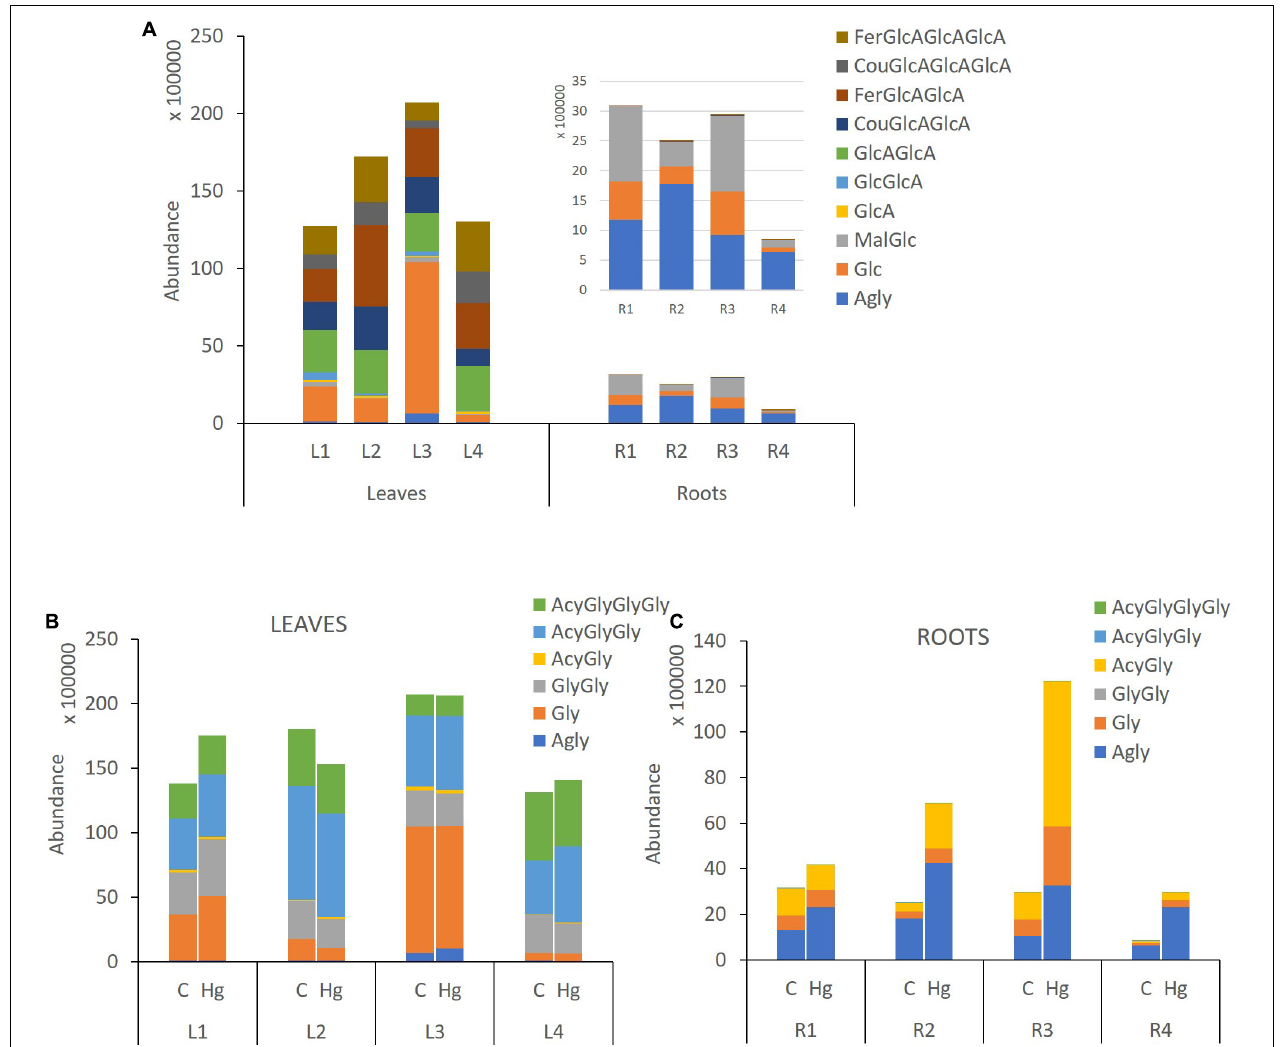
FIGURE 5 | Flavonoid glycosylation profile in leaves and roots of Medicago truncatula . (A) Control samples, (B) Control vs Hg-treated varieties of leaves, and (C) Control vs Hg-treated varieties of roots. Agly, aglicone; GlcA, glucuronic acid; Glc, glucose; Mal, malonic acid; Fer, ferrulic acid; Cou, Coumaric acid;